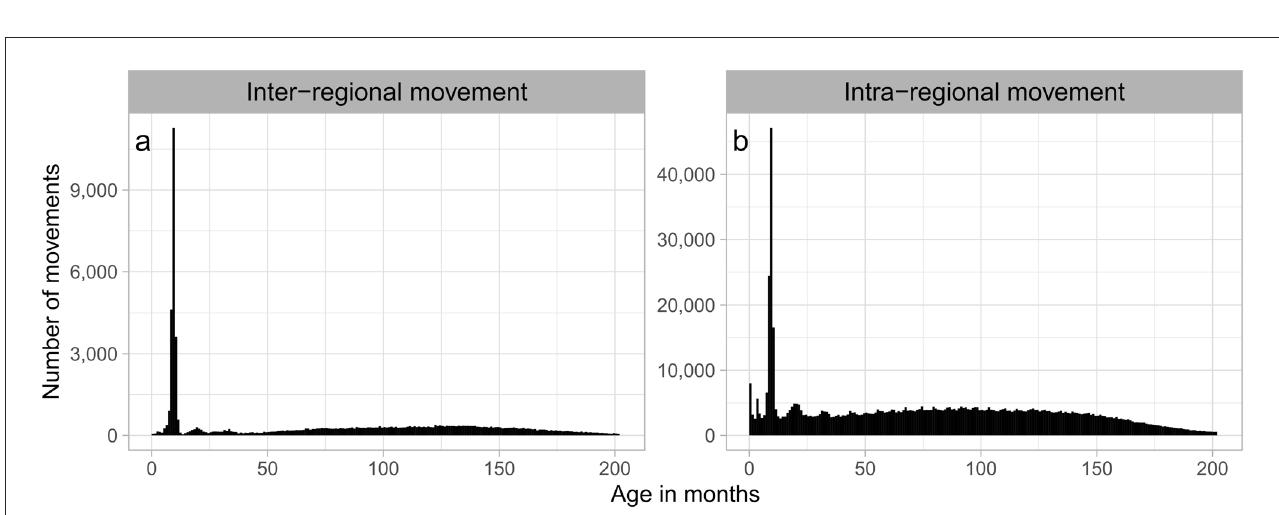
FIGURE4 Age distribution of beef cows that moved within regions (a) and between regions (b) in Japan from FY2012 to